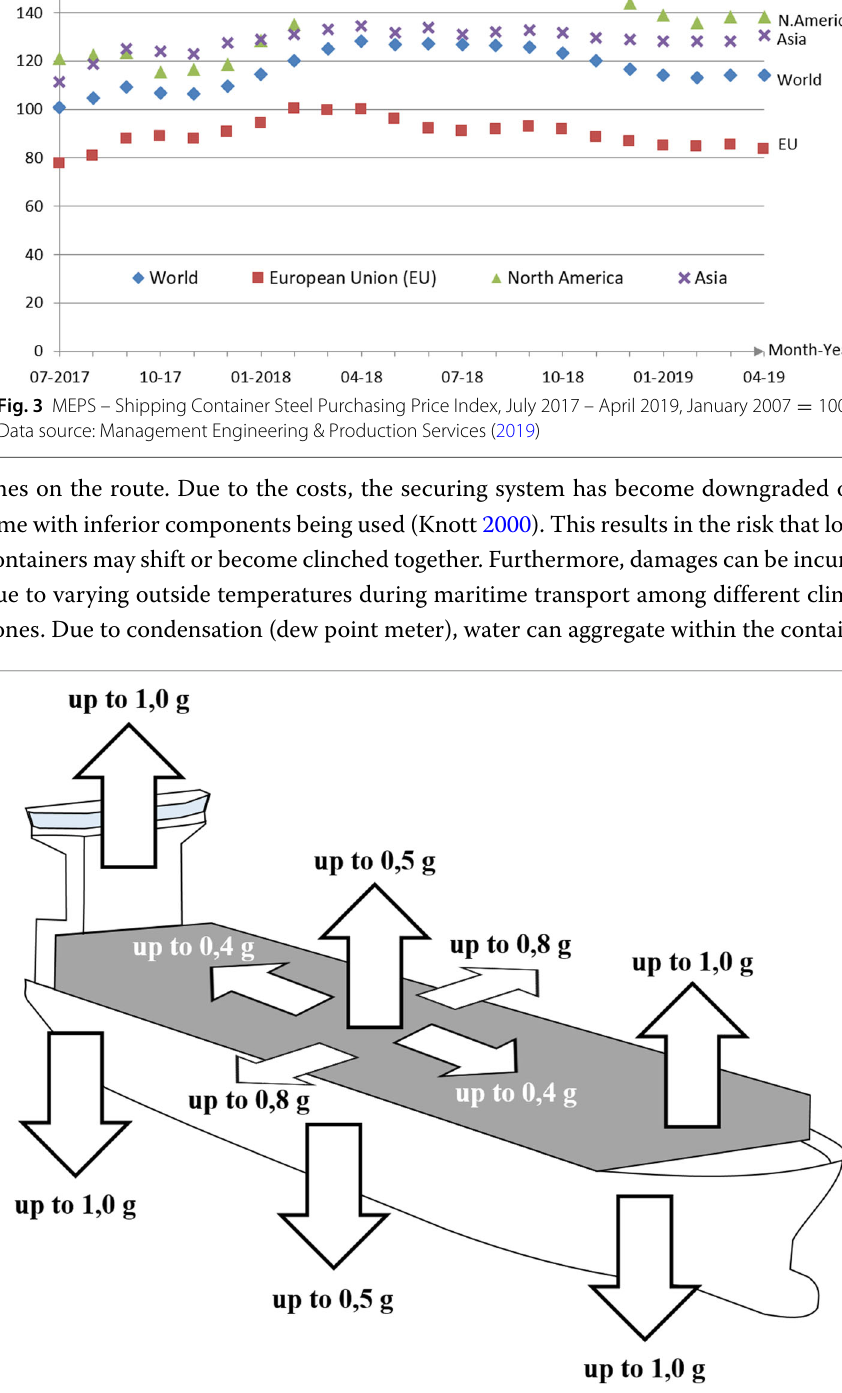
Fig. 4 Potential acceleration during maritime transport depending on the stowage place of the container (based on Hapag-Lloyd Container Line – Special Cargo Department (2005), p.